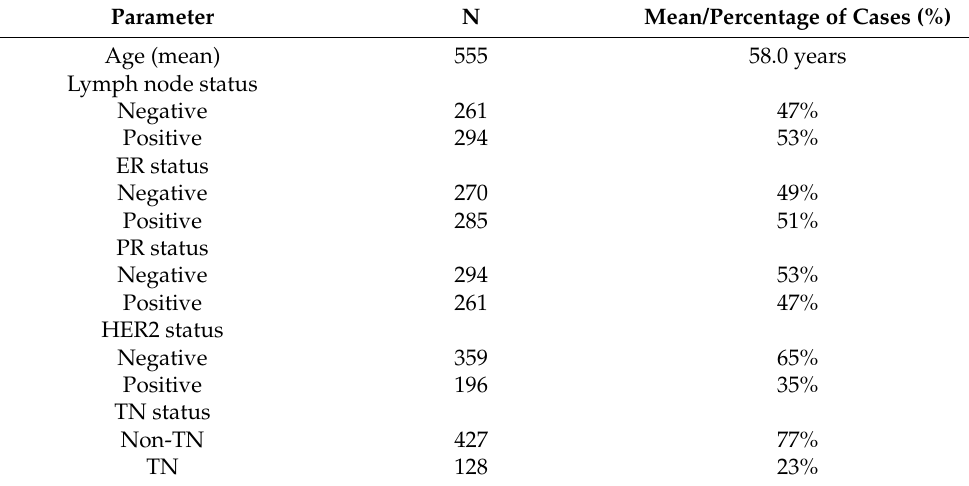
Table 1. Patient characteristics in YTMA-49. Parameter N Mean/Percentage of Cases